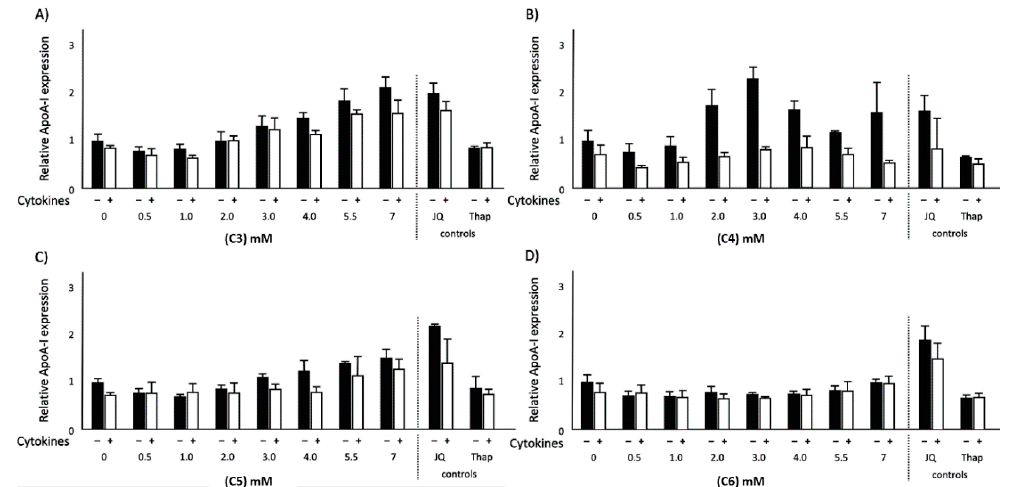
Figure 1. Relative apolipoprotein A ‐ I (ApoA ‐ I) mRNA expression in HepG2 cells treated